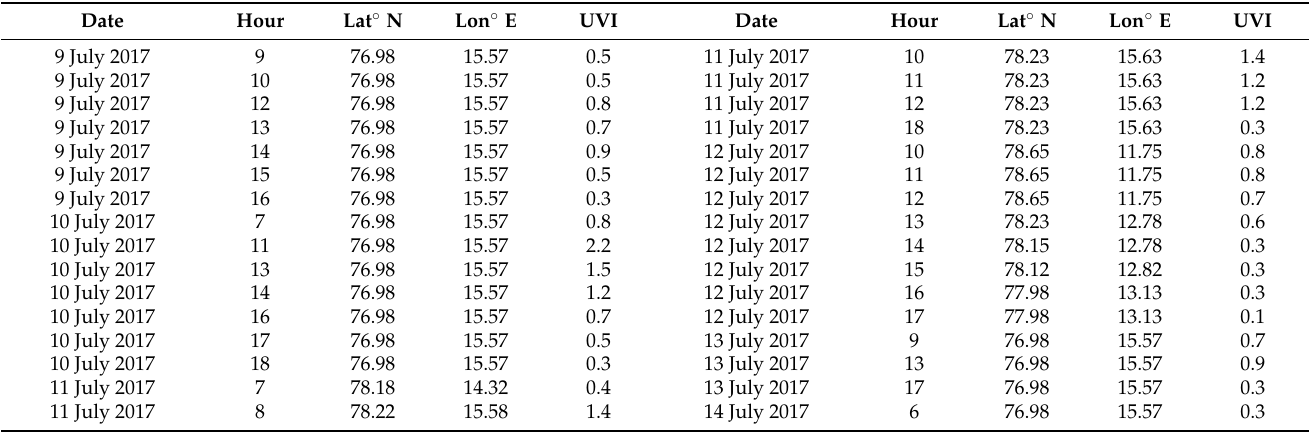
Table A2. The same as Table A1 but during the MS Horyzont II stay in Svalbard in the period 9–14 July 2017 (days 190–195).